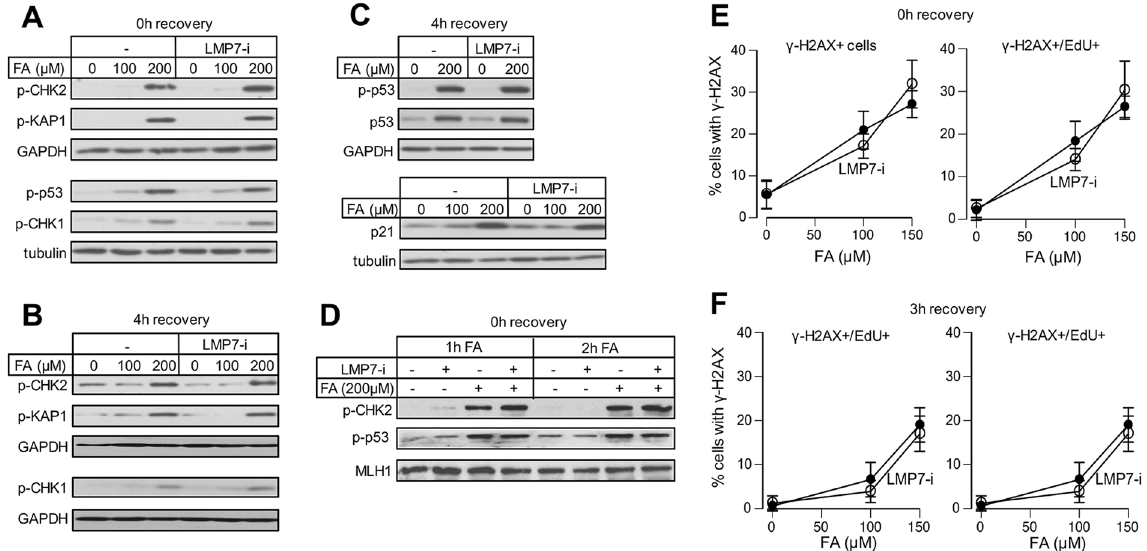
Figure 3. Genotoxic signaling in H460 cells. Cells were treated with FA for 3 h except for panel D. LMP7-i (0.5 μ M) was present during and after FA treatments (p-CHK2, p-CHK1, p-KAP1, p-p53: phosphorylated forms). ( A ) Genotoxic signaling at 0 h or ( B ) 4 h recovery after FA exposure. ( C ) Westerns for markers of p53 activation at 4 h recovery post-FA. ( D ) Phosphorylation of CHK2 and p53 in cells treated with FA for 1 or 2 h. ( E ) Percentage of cells containing γ –H2AX foci ( γ –H2AX + ) and both γ –H2AX foci and EdU staining ( γ –H2AX + /EdU + ) (means ± SD, n = 3). ( F ) As panel E except that cells were fixed at 3 h post-FA exposure (means ± SD, n =